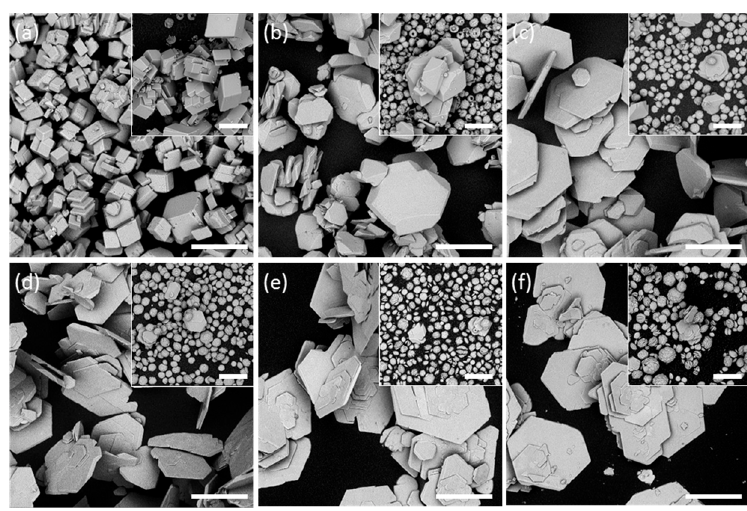
Figure 3. Scanning electron images of calcium carbonate samples obtained after 5 days of aging in the reference system, c (Li + ) = 0 ( a ) and in the systems with c (Li + ) = 0.1 mol dm –3 ( b ), c (Li + ) = 0.3 mol dm –3 ( c ), c (Li + ) = 0.5 mol dm –3 ( d ), c (Li + ) = 0.7 mol dm –3 ( e ) and c (Li + ) = 1.0 mol dm –3 ( f ). The inset shows the precipitates obtained after 10 min of ultrasonic irradiation at P = 40 W and at room temperature. Scale bars: 20 µm.